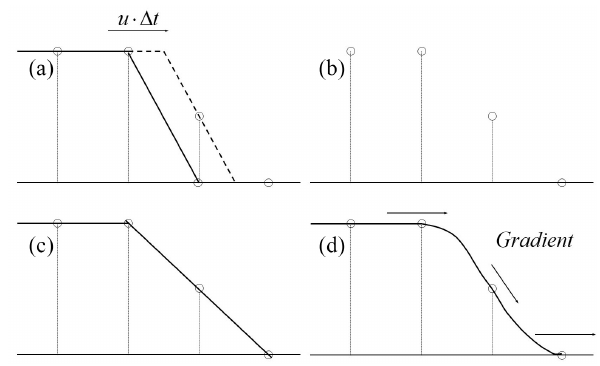
Figure 1. The principle of CIP method: (a) the solid line is the initial profile and the dashed line is an exact solution after ad- vection; (b) discretized points after advection; (c) linearly interpo- lated; (d) interpolated using CIP